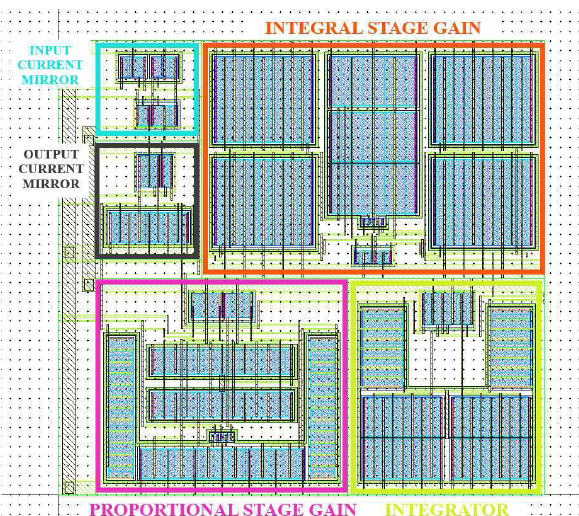
Figure 17. Chip layout design of the complete controller.